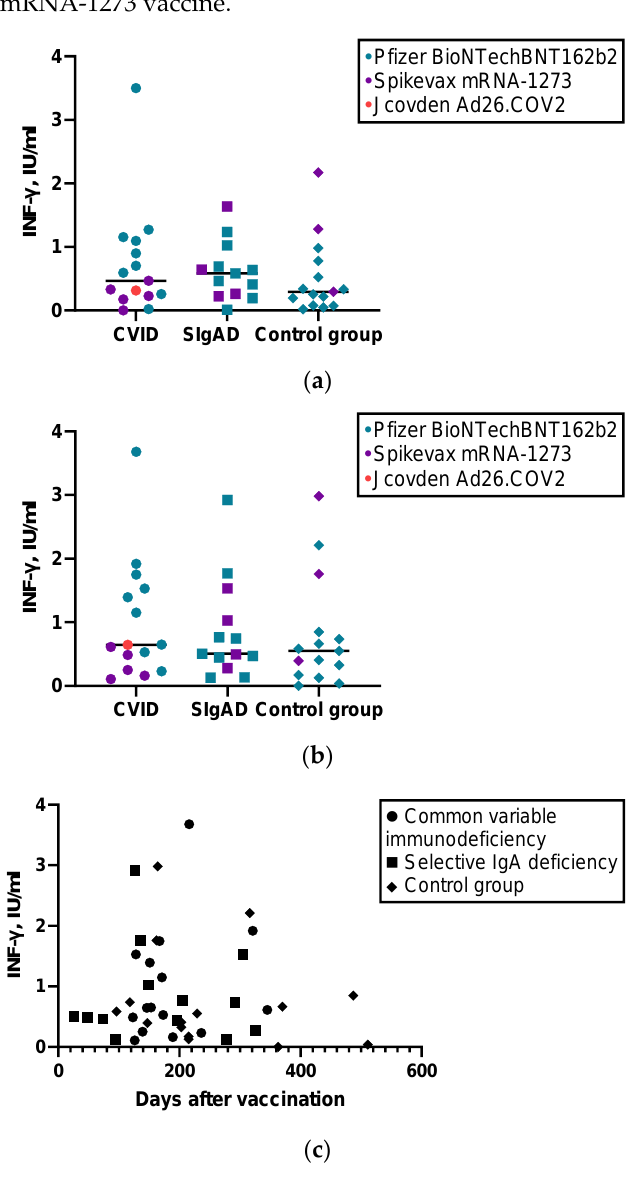
Figure 2. ( a ) CD4+ cell response (levels of INF-y) to S1 pool-specific protein in different groups; ( b ) CD4+ and CD8+ cell response (levels of INF-y) to S1/S2 pool-specific protein in different groups; ( c ) Correlation between anti-spike CD4+ and CD8+ cell response and days after vaccination.